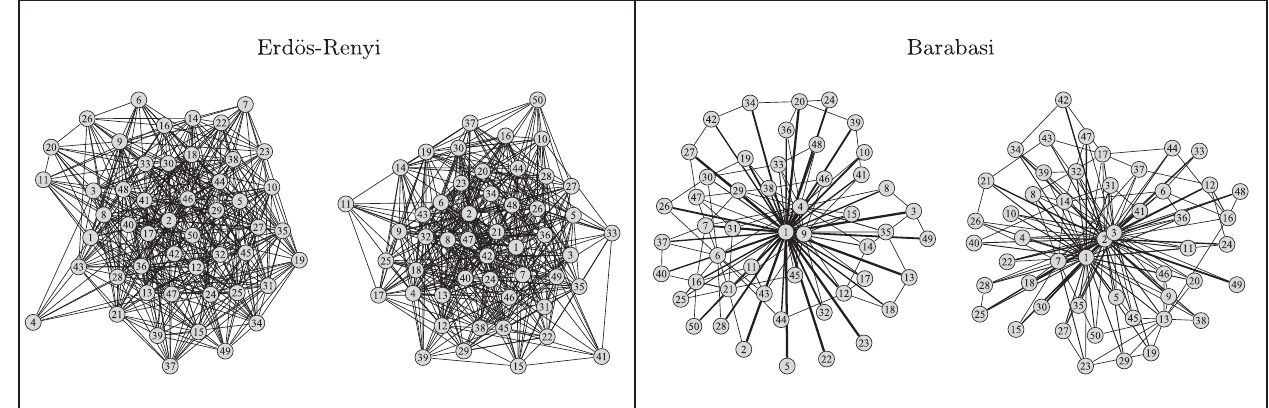
FIG. 8. Erdo¨s-Renyi and Barabasi graphs. The two graphs on the left are Erdo¨s-Renyi graphs created using optimized parameters that best fit the 3-cycle distributions of experts and novices. On the right, we see two Barabasi graphs.